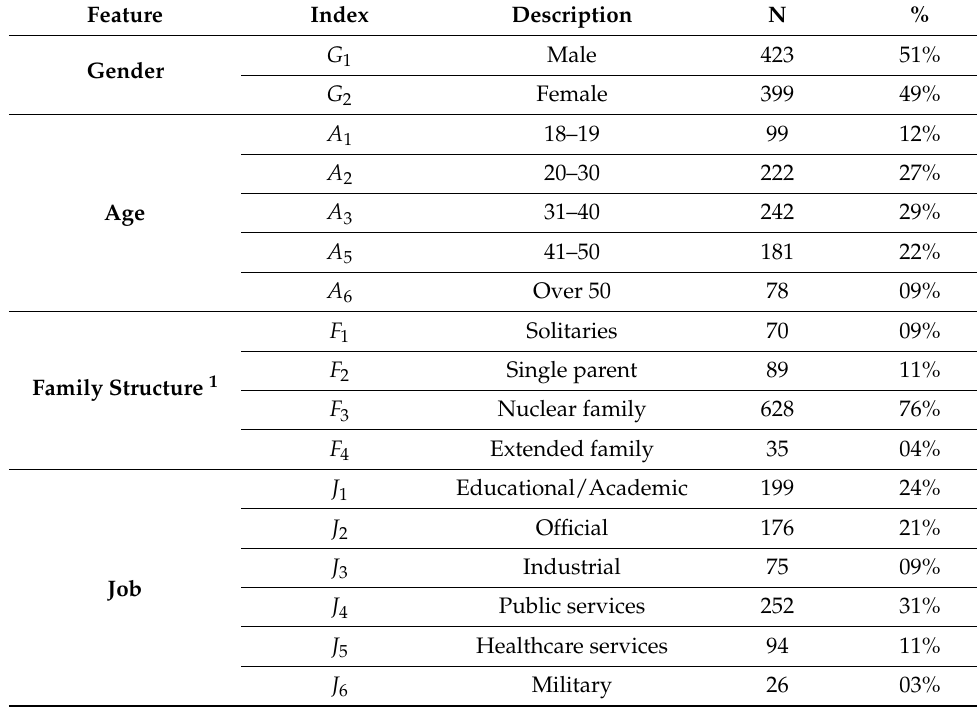
Table 1. Socio-demographic characteristics of the participants.